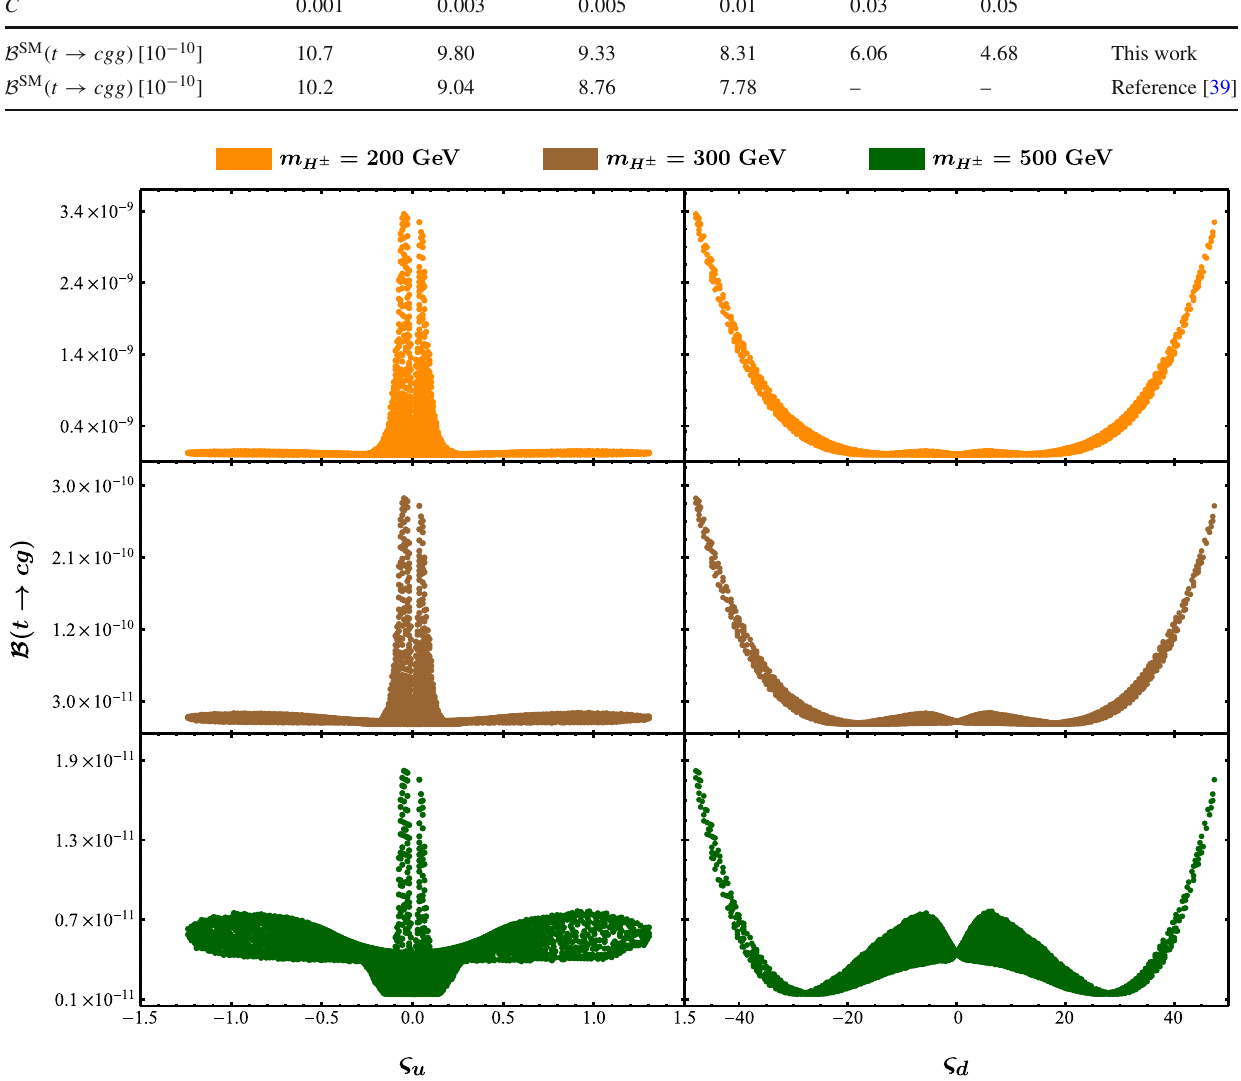
quarks as well as the α scheme for the electroweak parameters were used in Ref. [39]